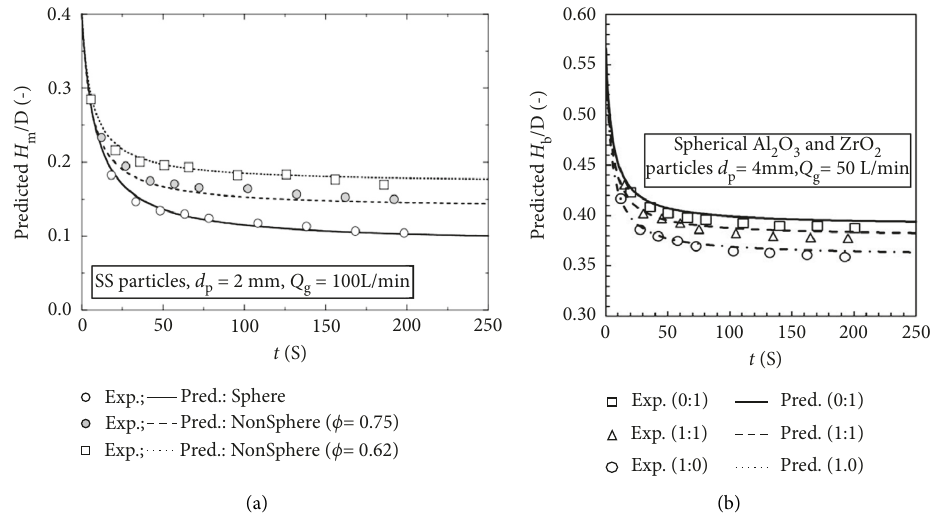
Figure 18: Variations of mound and bed heights in experiments and modeling predictions [43, 46] (a) Effect of particle shape on variation of Hm (b) Effect of mixed-density on variation of Hb